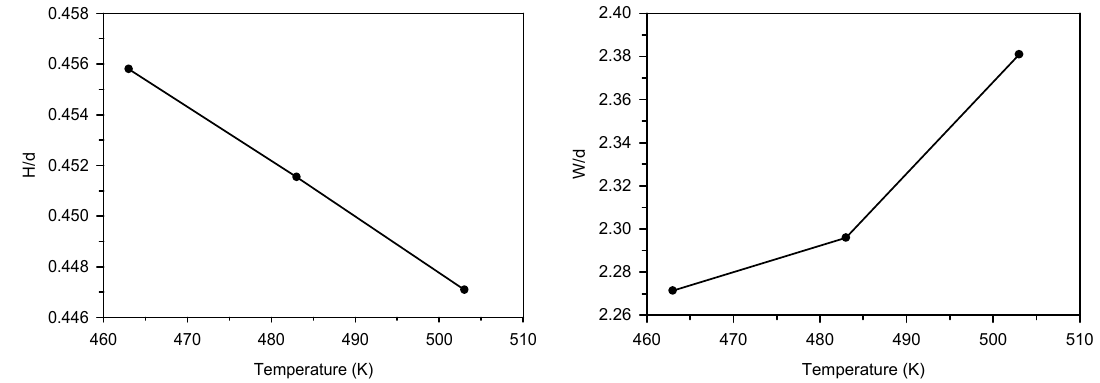
Figure 12. The effect of nozzle temperature on H / d ( Left ) and W / d ( Right ) of strands obtained from simulation ( g / d = 0.4 and U /< u > = 1). (Lines connecting symbols are for visual guidance).